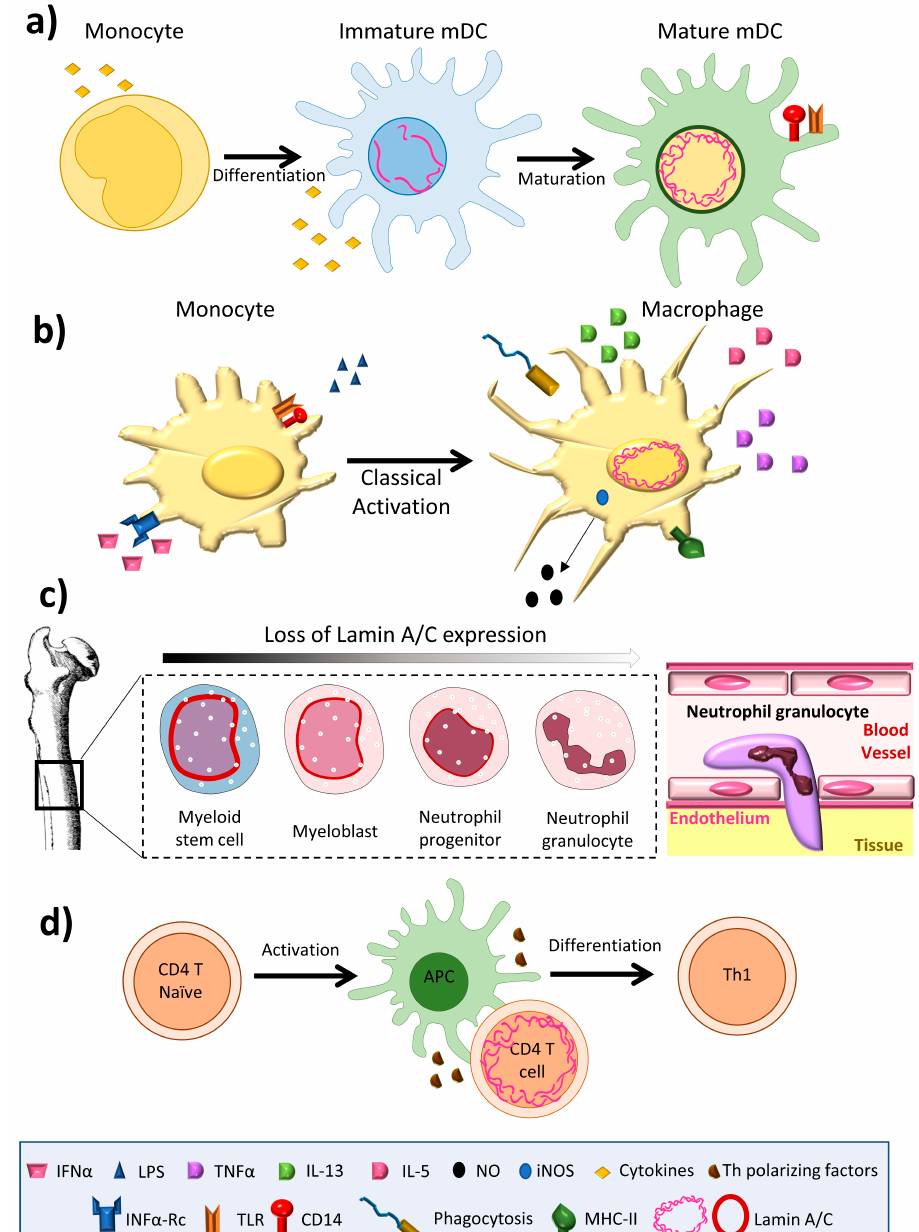
Figure 1. Lamin A / C levels are finely regulated in immune cells. ( a ) Dendritic cells have an intermediate Figure 1. Lamin A/C levels are finely regulated in immune cells. ( a ) Dendritic cells have an lamin A / C content, between that of neutrophils and macrophages, which is associated with intermediate intermediate lamin A/C content, between that of neutrophils and macrophages, which is associated viability and migration. ( b ) Macrophages increase lamin A / C content upon di ff erentiation and activation. with intermediate viability and migration. ( b ) Macrophages increase lamin A/C content upon differentiation and activation. ( c ) During granulopoiesis, neutrophil precursors change their round ( c ) During granulopoiesis, neutrophil precursors change their round nuclear shape for a characteristic nuclear shape for a characteristic lobed nucleus, a process linked to almost complete loss of lamin A/C lobed nucleus, a process linked to almost complete loss of lamin A / C expression and augmented expression of the lamin B receptor (LBR). Neutrophil loss of lamin A / C enables them to pass through narrow spaces. ( d ) T cells show a transient peak in lamin A / C expression upon recognition of an antigen presented by an antigen presenting